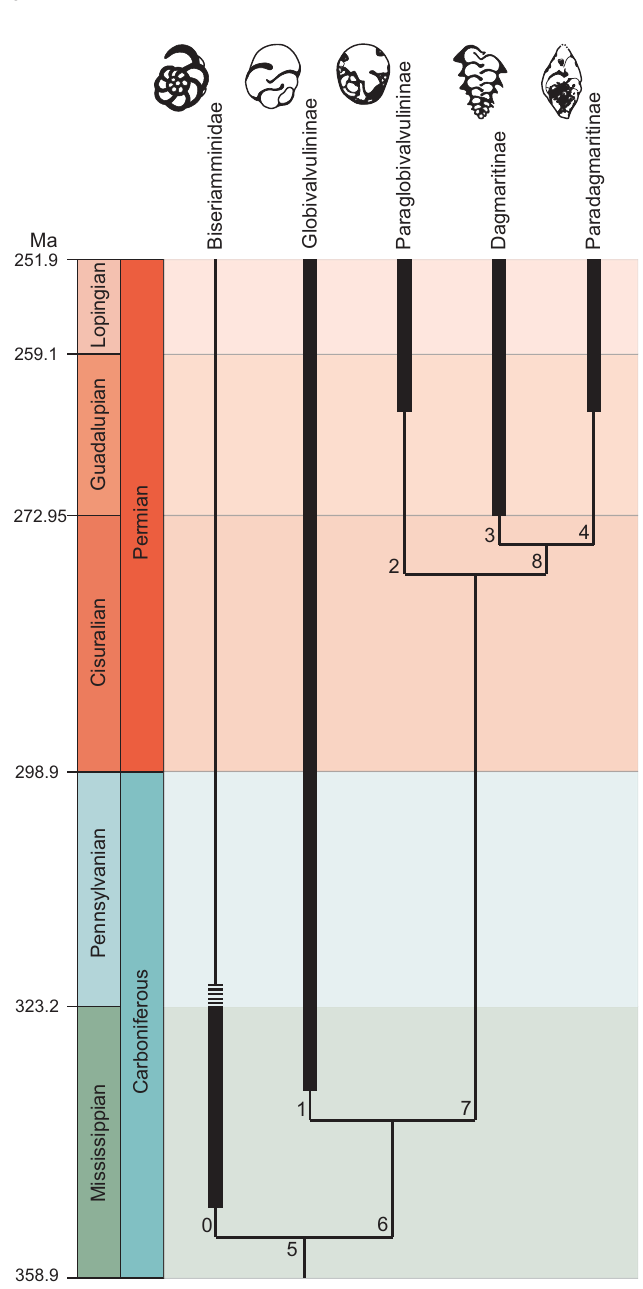
Fig. 3. Phylogenetic tree resulting from the cladistic analysis. Thick lines represent the known stratigraphic ranges of the considered taxa (dashed line indicates uncertain stratigraphic ranges). Nodes are numbered above branches. See text and Appendix 1 for